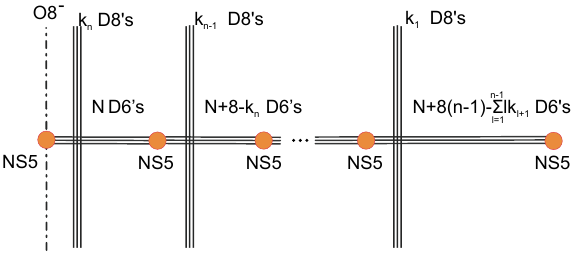
Figure 34 . Type IIA brane con(cid:12)guration for the 6d linear quiver theory